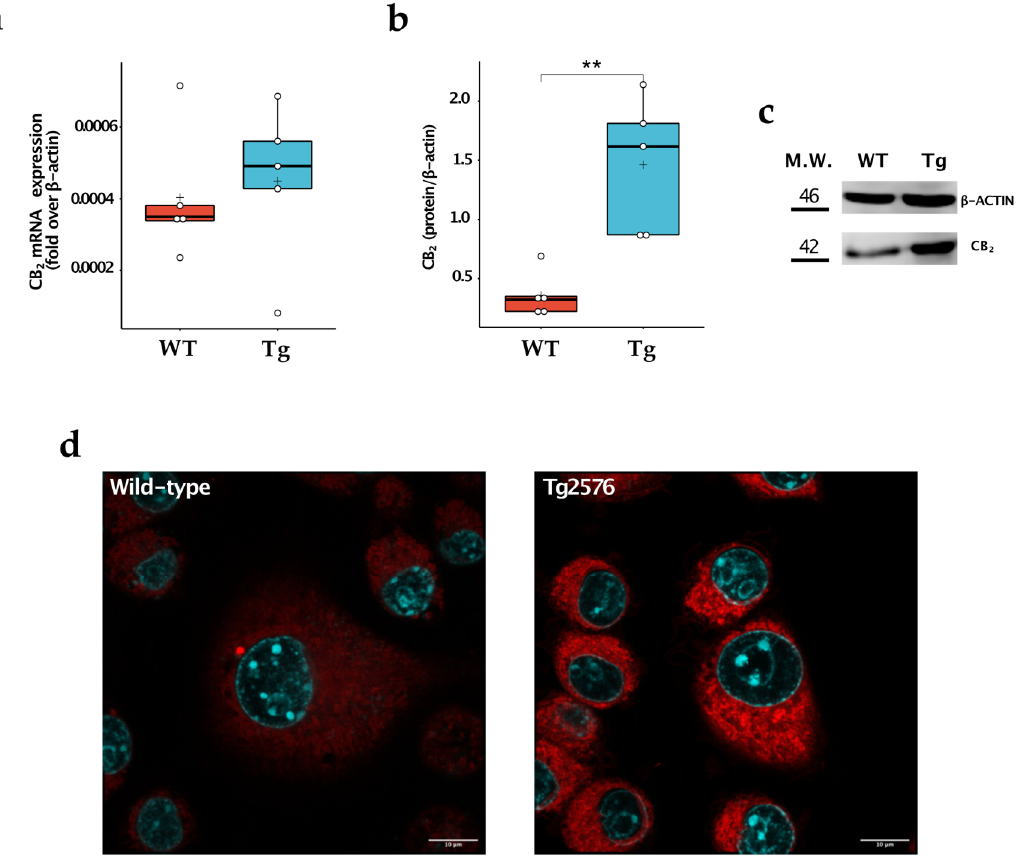
Figure 3. Study of CB 2 expression in wild-type (WT) and Tg2576 (Tg) microglia. ( a ) CB 2 was quantified for its mRNA content by quantitative real-time polymerase chain reaction and ( b ) for its protein expression by Western blot analysis. Horizontal line and + within the rectangle (boxplot) represent the median and the mean, respectively, of the values of five independent experiments (white circles). Significance is shown as a p value, calculated using an unpaired t-test. ** p < 0.01. ( c ) Representative immunoblot showing the expression of the indicated protein. ( d ) Super-resolution fluorescence microscopy in microglial cells using probe 8-SiR. Cells were pre-stained with Hoechst 33,342 (cyan) to counterstain the nuclei and then incubated for 20 min with 0.25 µ M 8-SiR (red). See also AVI Videos S1 and